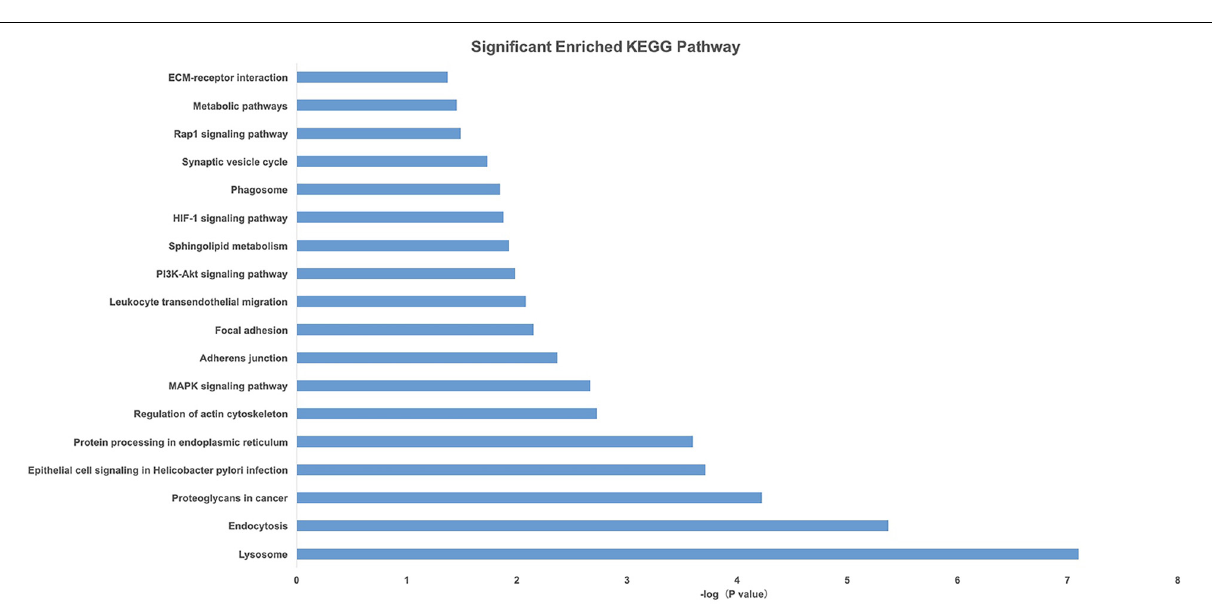
FIGURE 5 | Pathway analysis of candidate genes. A higher –Log10( p -value) indicates a smaller p